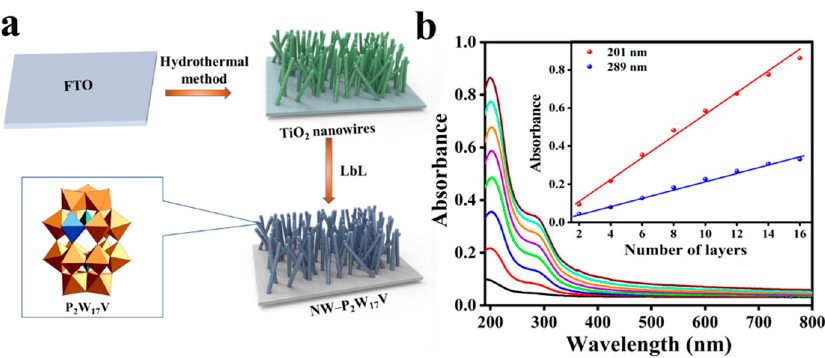
Figure 1. Characterization of material preparation process. ( a ) Schematic outline of the fabrication process of nanocomposite film; ( b ) UV-vis absorption spectra of composite film on quartz substrate (number of cycles: 2–16). Inset: plots of the absorbance values at 201 and 289 nm as a function of the layer number.